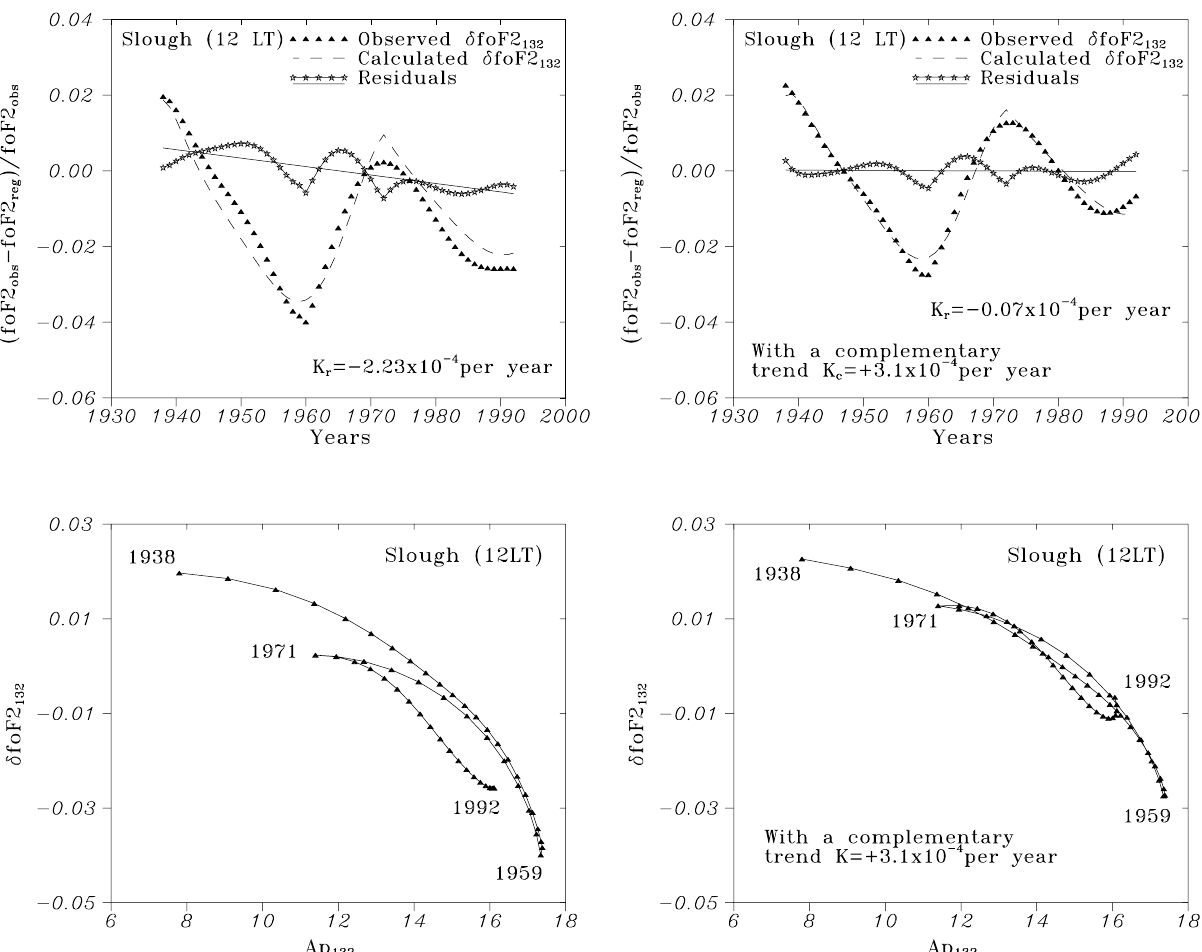
Fig. 3. Observed, calculated δ fo F2 132 and their difference resulting in a residual fo F2 trend with the slope K r for Slough 12:00LT (top panels), along with the relationship between polynomial approximated δ fo F2 132 and Ap 132 (bottom panels). Right-hand panels show the results with a complementary trend ( K c = + 3 . 1 × 10 − 4 per year). Note the tightening of two branches in the δ fo F2 132 versus Ap 132 dependence (left-hand, bottom) after applying a complementary trend (right-hand,